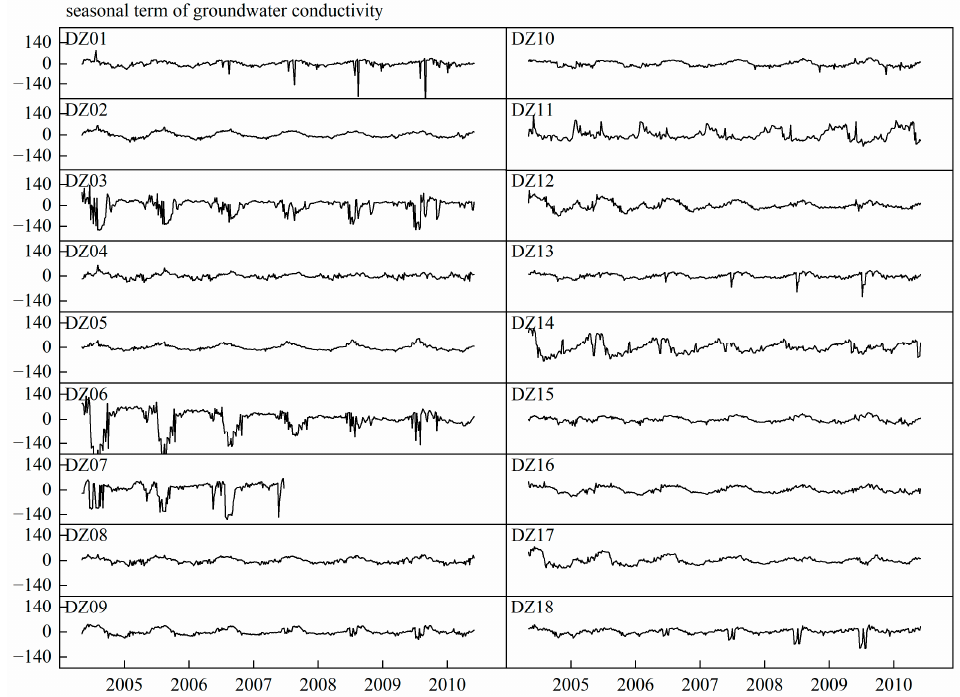
Figure A4. The seasonal term of groundwater EC of each observational well varies with time.